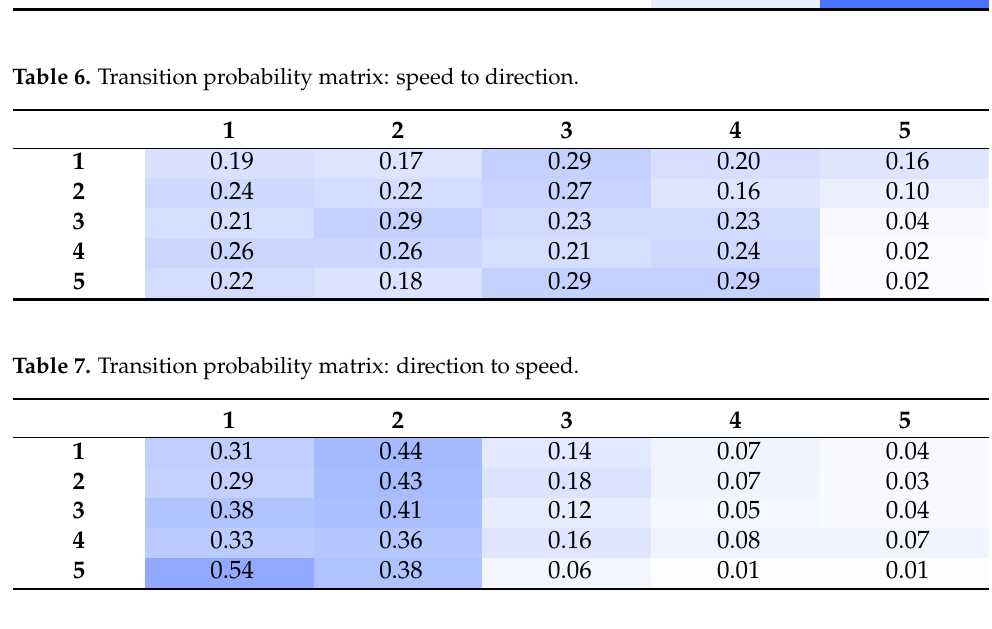
Table 8. Transition probability matrix: direction to direction.